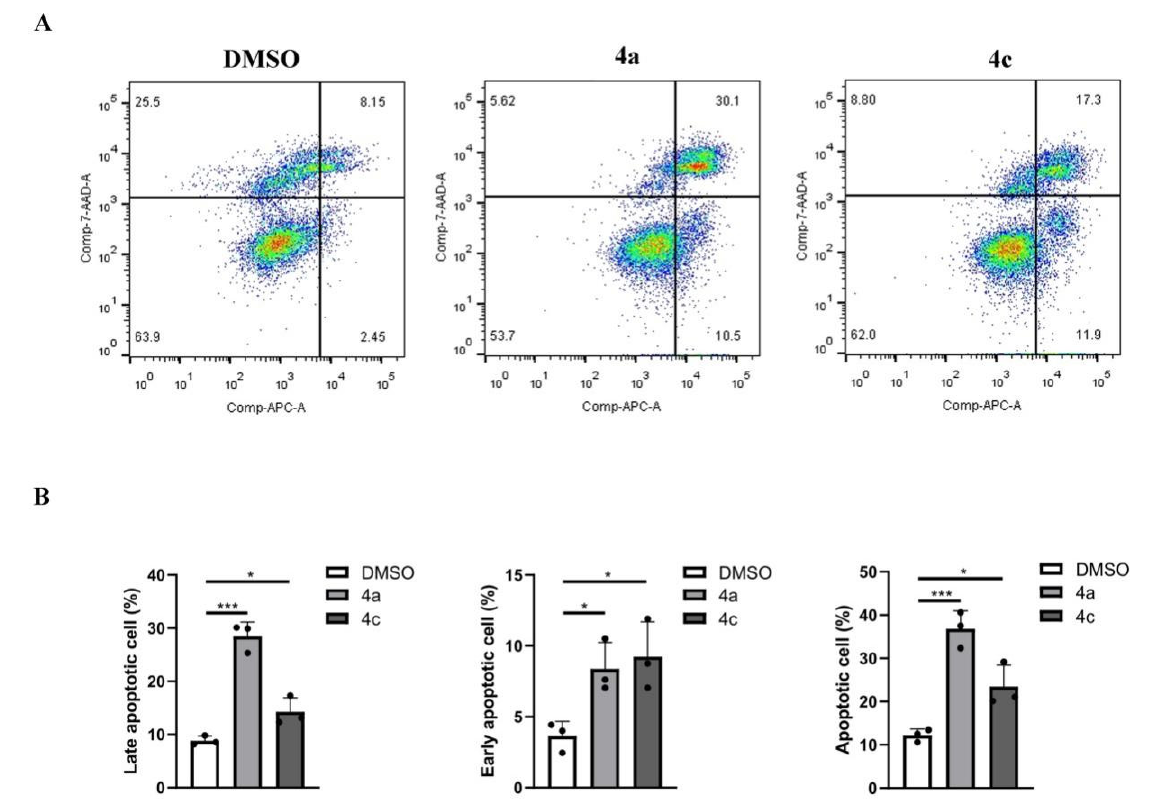
Figure 4. Cell apoptosis analysis using Annexin V-APC/7-AAD staining and flow cytometry in LNCaP cells treated with complexes: ( A ) representative image of cell apoptosis analysis with flow cytometry. Early-stage apoptotic cells are presented in the lower right quadrants (Annexin V-APC positive and 7AAD negative), and late-stage apoptotic cells are presented in the upper right quadrants (Annexin V-APC and 7AAD positive); ( B ) quantitative analysis of early, late-stage, and total apoptotic cell percentage in LNCaP cells treated with compounds. All experiments were repeated three times for data analysis. (* p < 0.05, *** p < 0.001, • represents the results obtained from three independent experiments).